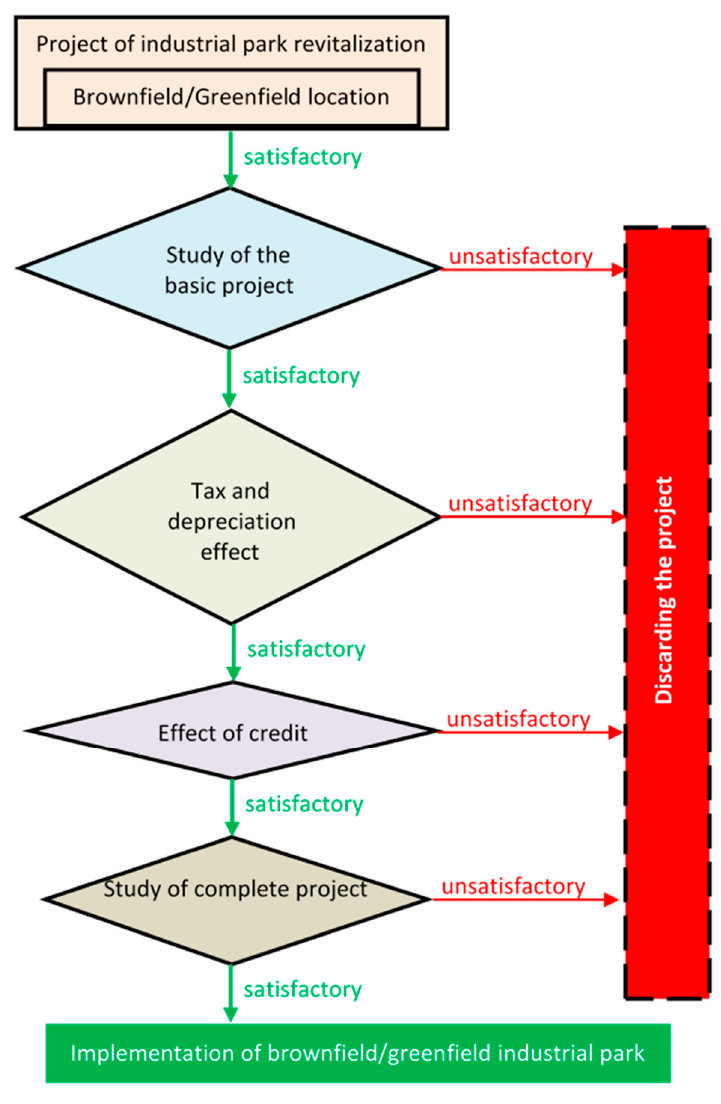
Figure 1. An assessment of the economic efficiency of an investment.